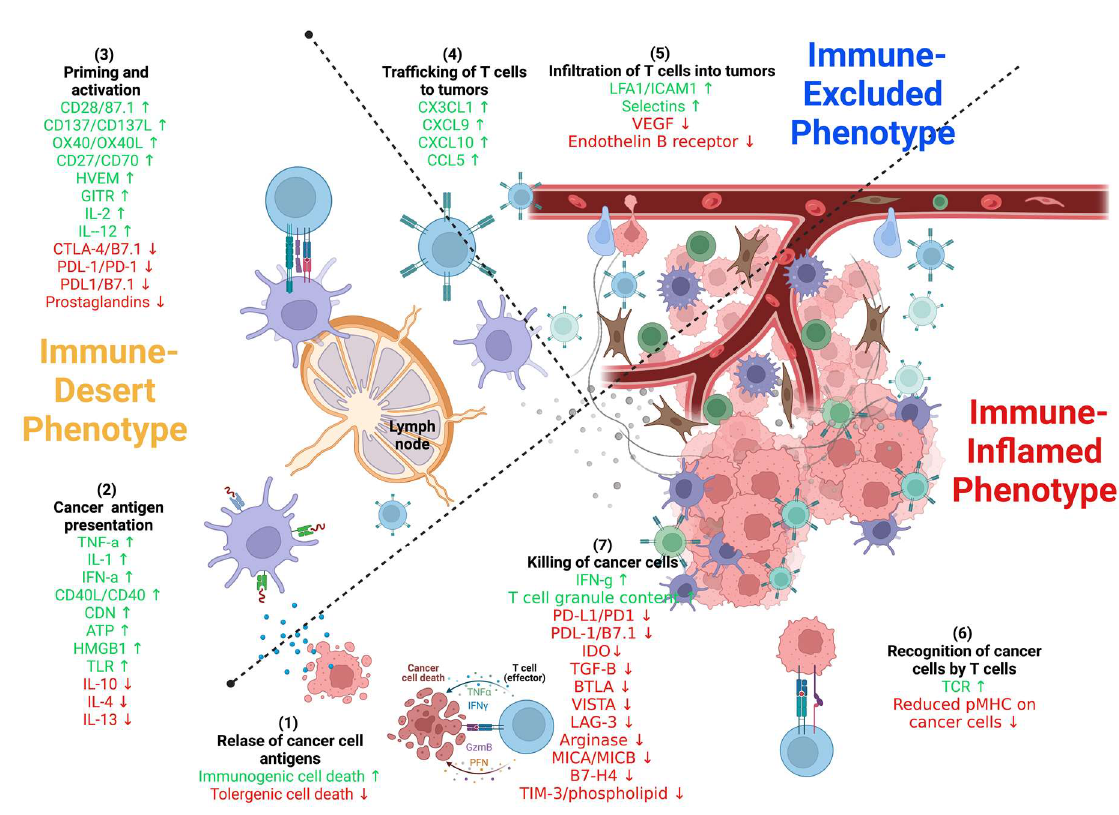
Figure 3. Stimulatory and inhibitory factors in the cancer-immunity cycle. Each step of the cancer-immunity cycle requires the coordination of several stimulatory and inhibitory factors. Stimulatory factors shown in green with the upward arrow ( ↑ ) indicating promotion of immunity. Inhibitors shown in red with the downward arrow ( ↓ ) help keep the process in check and reduce immune activity and/or prevent autoimmunity. Examples of such factors and the primary steps at which they can act are shown. Antitumor immunity is mediated predominantly by CD8+ T cells and tumor immunity involves: (1) tumor antigen release, (2) tumor antigen processing and presentation by APCs (e.g., dendritic cells), (3) priming and activation of T cells, (4) trafficking of T cells via the bloodstream to tumors, (5) infiltration of activated T cells into the tumor parenchyma from the vasculature or tumor periphery, (6) recognition of tumor cells through antigenic peptide-MHC complexes on the surface of tumor cells by T cells, and (7) killing of tumor cells by cytotoxic T cells through granule exocytosis and release of perforin and granzyme or through the Fas/FasL pathway by inducing ferroptosis and pyroptosis. The release of additional antigens from dead tumor cells allows the continuation of the tumor-immunity cycle. Tumors with the immune-desert phenotype cannot pass steps 1–3 due to the absence of T cells in both the tumor and its margins. On the other hand, tumors with the immune-excluded phenotype cannot pass steps 4–5 due to the absence of T cells in the tumor bed. On the other hand, tumors with the immune-inflamed phenotype cannot pass steps 6–7 because of T cell exhaustion and checkpoint upregulation. Immune checkpoint proteins, such as PD1 and CTLA-4, can suppress the development of an active immune response by acting primarily at the level of T cell development and proliferation (step 3). Adapted from ref. [125] and [124]. Created with BioRender.com (URL (accessed on 18-11-2022). Definitions of abbreviations are found in the abbreviations list at the end of the text.